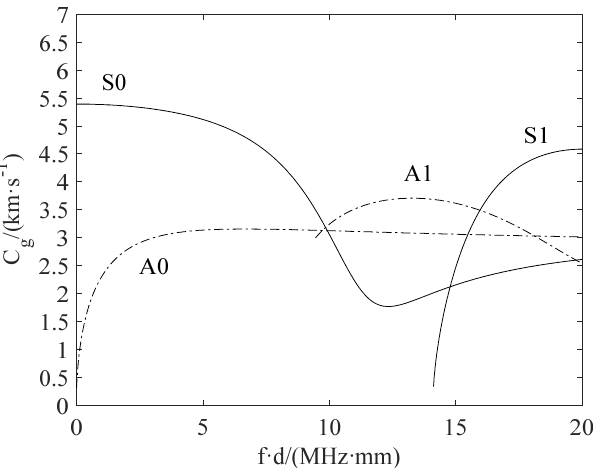
Figure 10. The dispersion curve of 2024 aluminum.